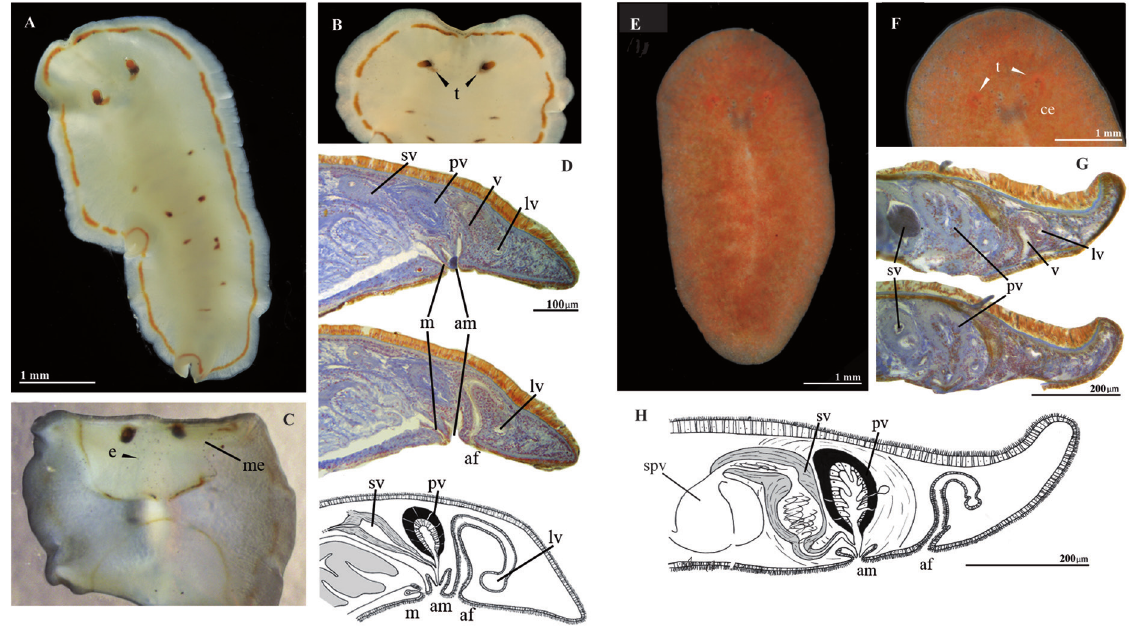
Fig. 5. A–D . Stylochus salis sp. nov. (MNCN 4.01/2719 to 2723). A . Whole live animal, dorsal view. B . Anterior region with eyes cluster and tentacles (black arrows). C Whole live animal ventral view. D . Histological sagittal sections of the reproductive system and sagittal reconstruction. – E–H . Distylochus fundae sp. nov. (MNCN 4.01/2724 to 2725). E . Whole live animal, dorsal view. F . Anterior region with cerebral eyes and tentacles (white arrows). G . Histological sagittal section of the reproductive system. H . Sagittal reconstruction of reproductive system. Abbreviations: see Material and